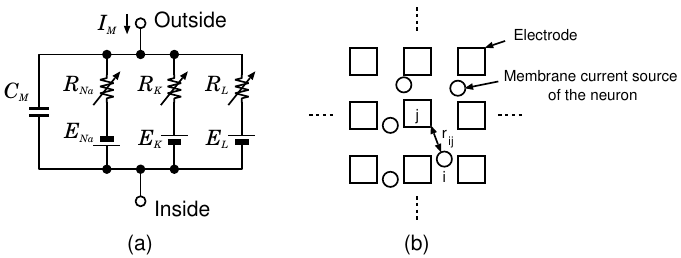
Figure A1. ( a ) Equivalent circuit of nerve membrane [49] and ( b ) electrodes arranged at equal intervals and randomly placed membrane current sources of